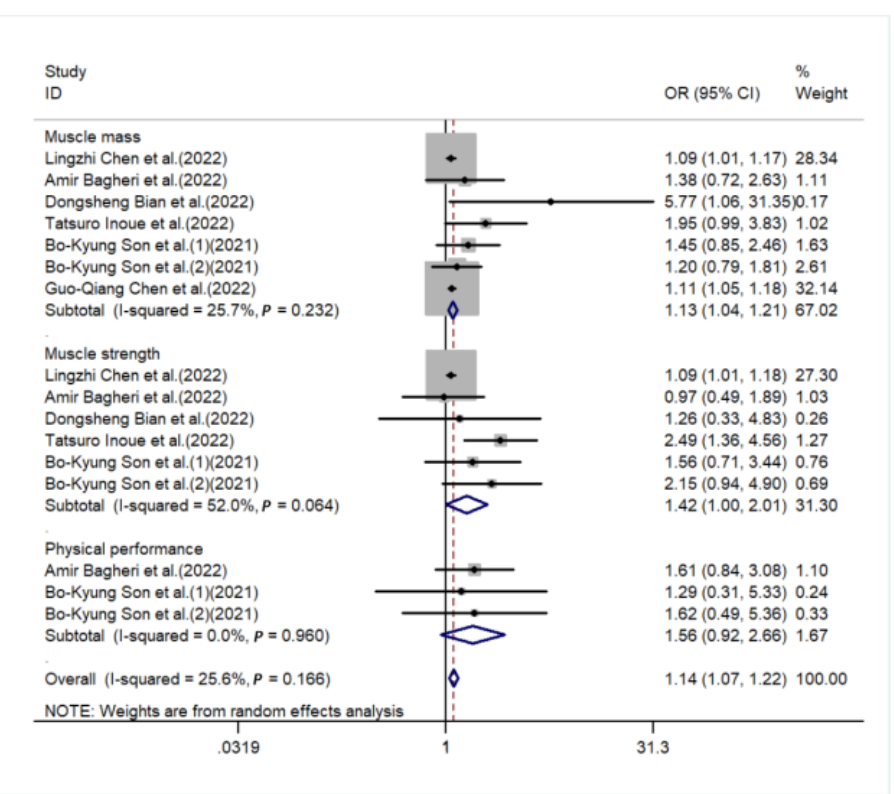
Figure 3. Forest plot for the subgroup of sex [20,24,26-28] .